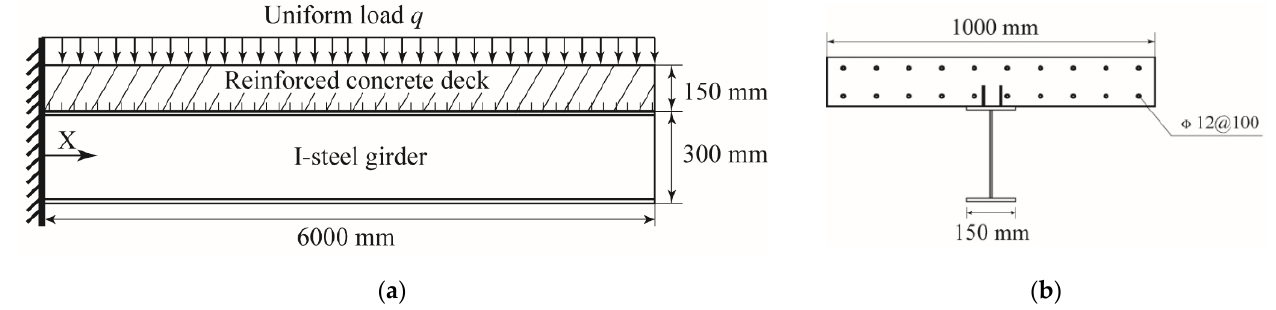
Figure 5. Schematic diagram of steel–concrete composite girder. ( a ) Evaluation view. ( b ) Cross-section profile. Table 3. Probabilistic description of the materials.